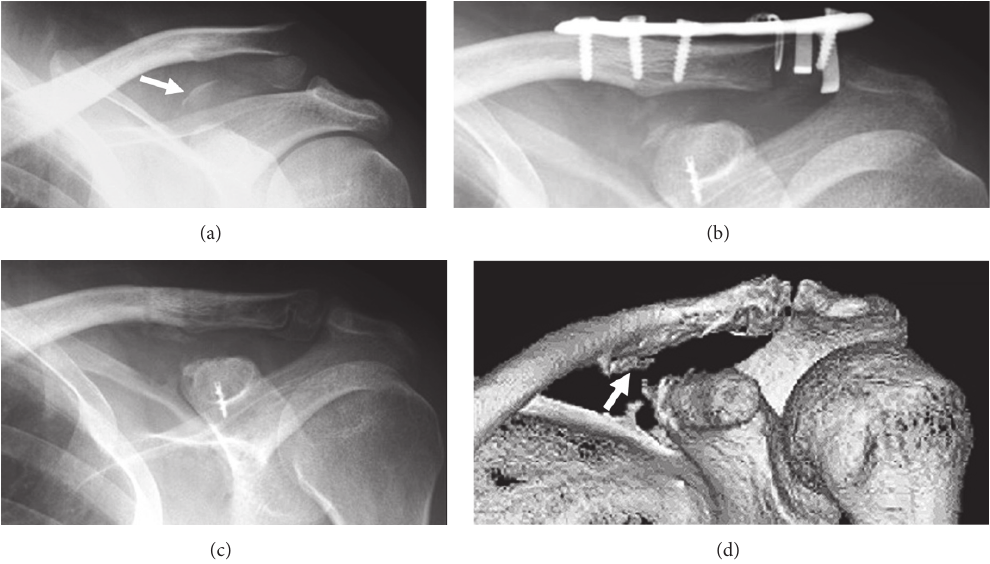
Figure 1: Imaging of Case 1. (a) Radiogram taken at the first visit showing distal clavicular fracture and avulsion fracture of the upper side of the coracoid process (arrow). (b) Postoperative radiogram revealing the well-reduced clavicular fracture and the fractured coracoid fragment. (c) Roentgenogram taken 1 year postoperatively indicating firm bony union of the distal clavicular and coracoid process fractures. (d) Three- dimensional computed tomography performed 1 year postoperatively demonstrating thin new bone formation at the conoid tubercle (arrow).